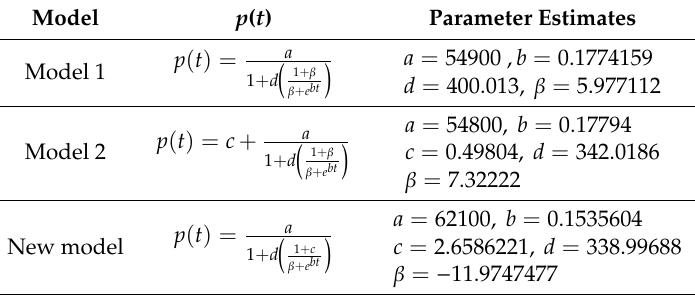
Table 4. Parameter estimates using least squares